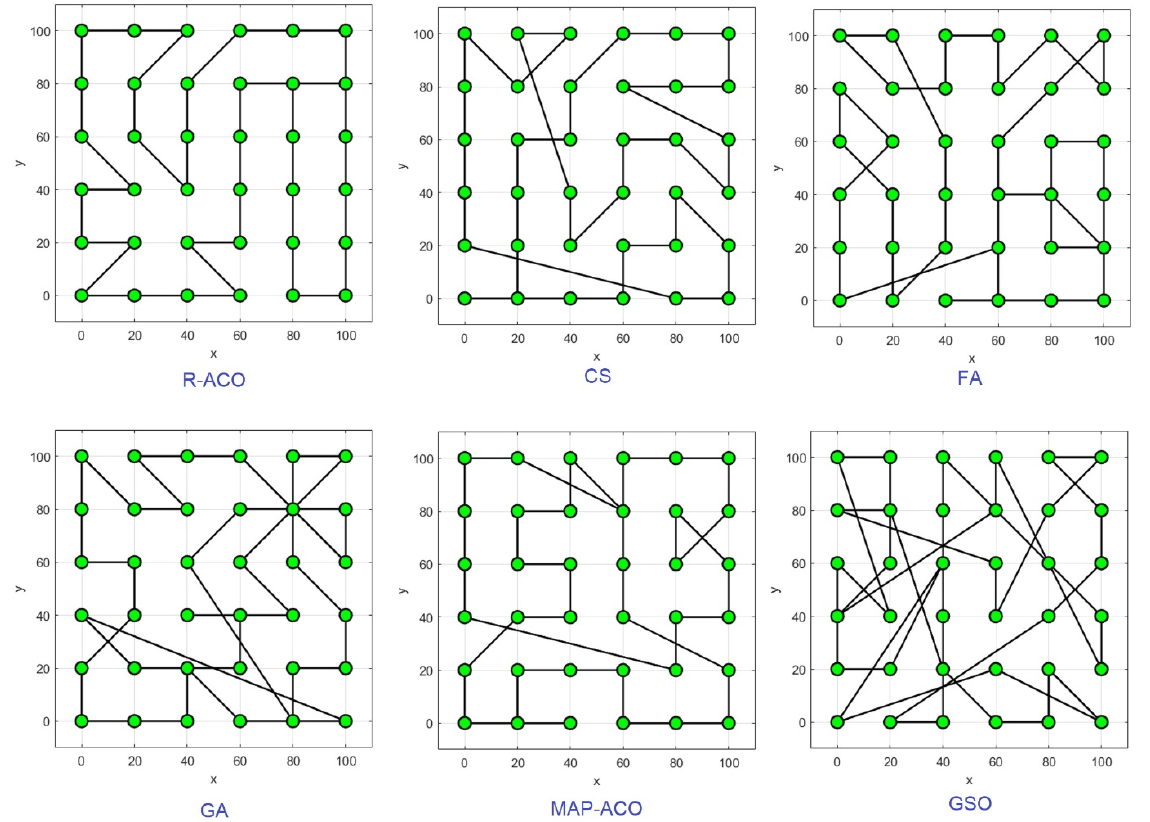
Figure 5. The elected path by each algorithm.